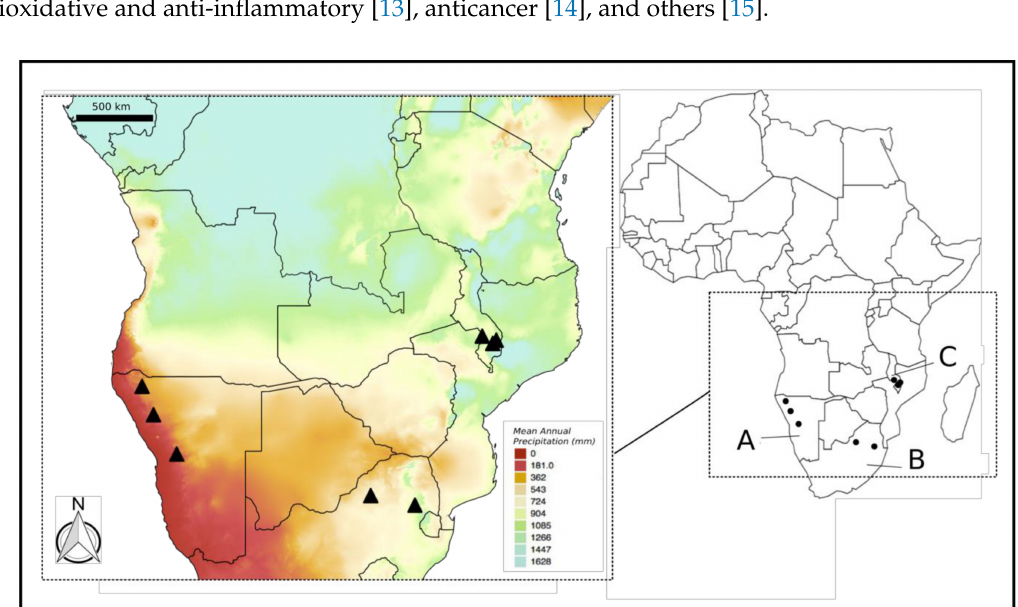
Figure 1. Map of mean annual precipitation (MAP) based on BIOCLIM variable 12 from www. worldclim.org/bioclim indicating the countries referred to in the text; A : Namibia, B : South Africa, and C : Malawi. The sampling sites in the present study are also indicated by black triangles. The map was produced in Quantum (Q) GIS v. 2.14 “Essen”